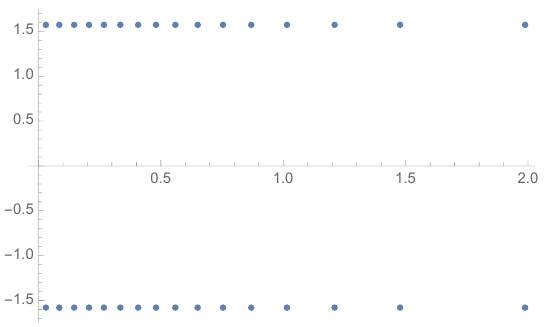
Figure 14 . Bethe roots for L = 32. Ground state in the n = 0 sector with (cid:13) = (cid:25)